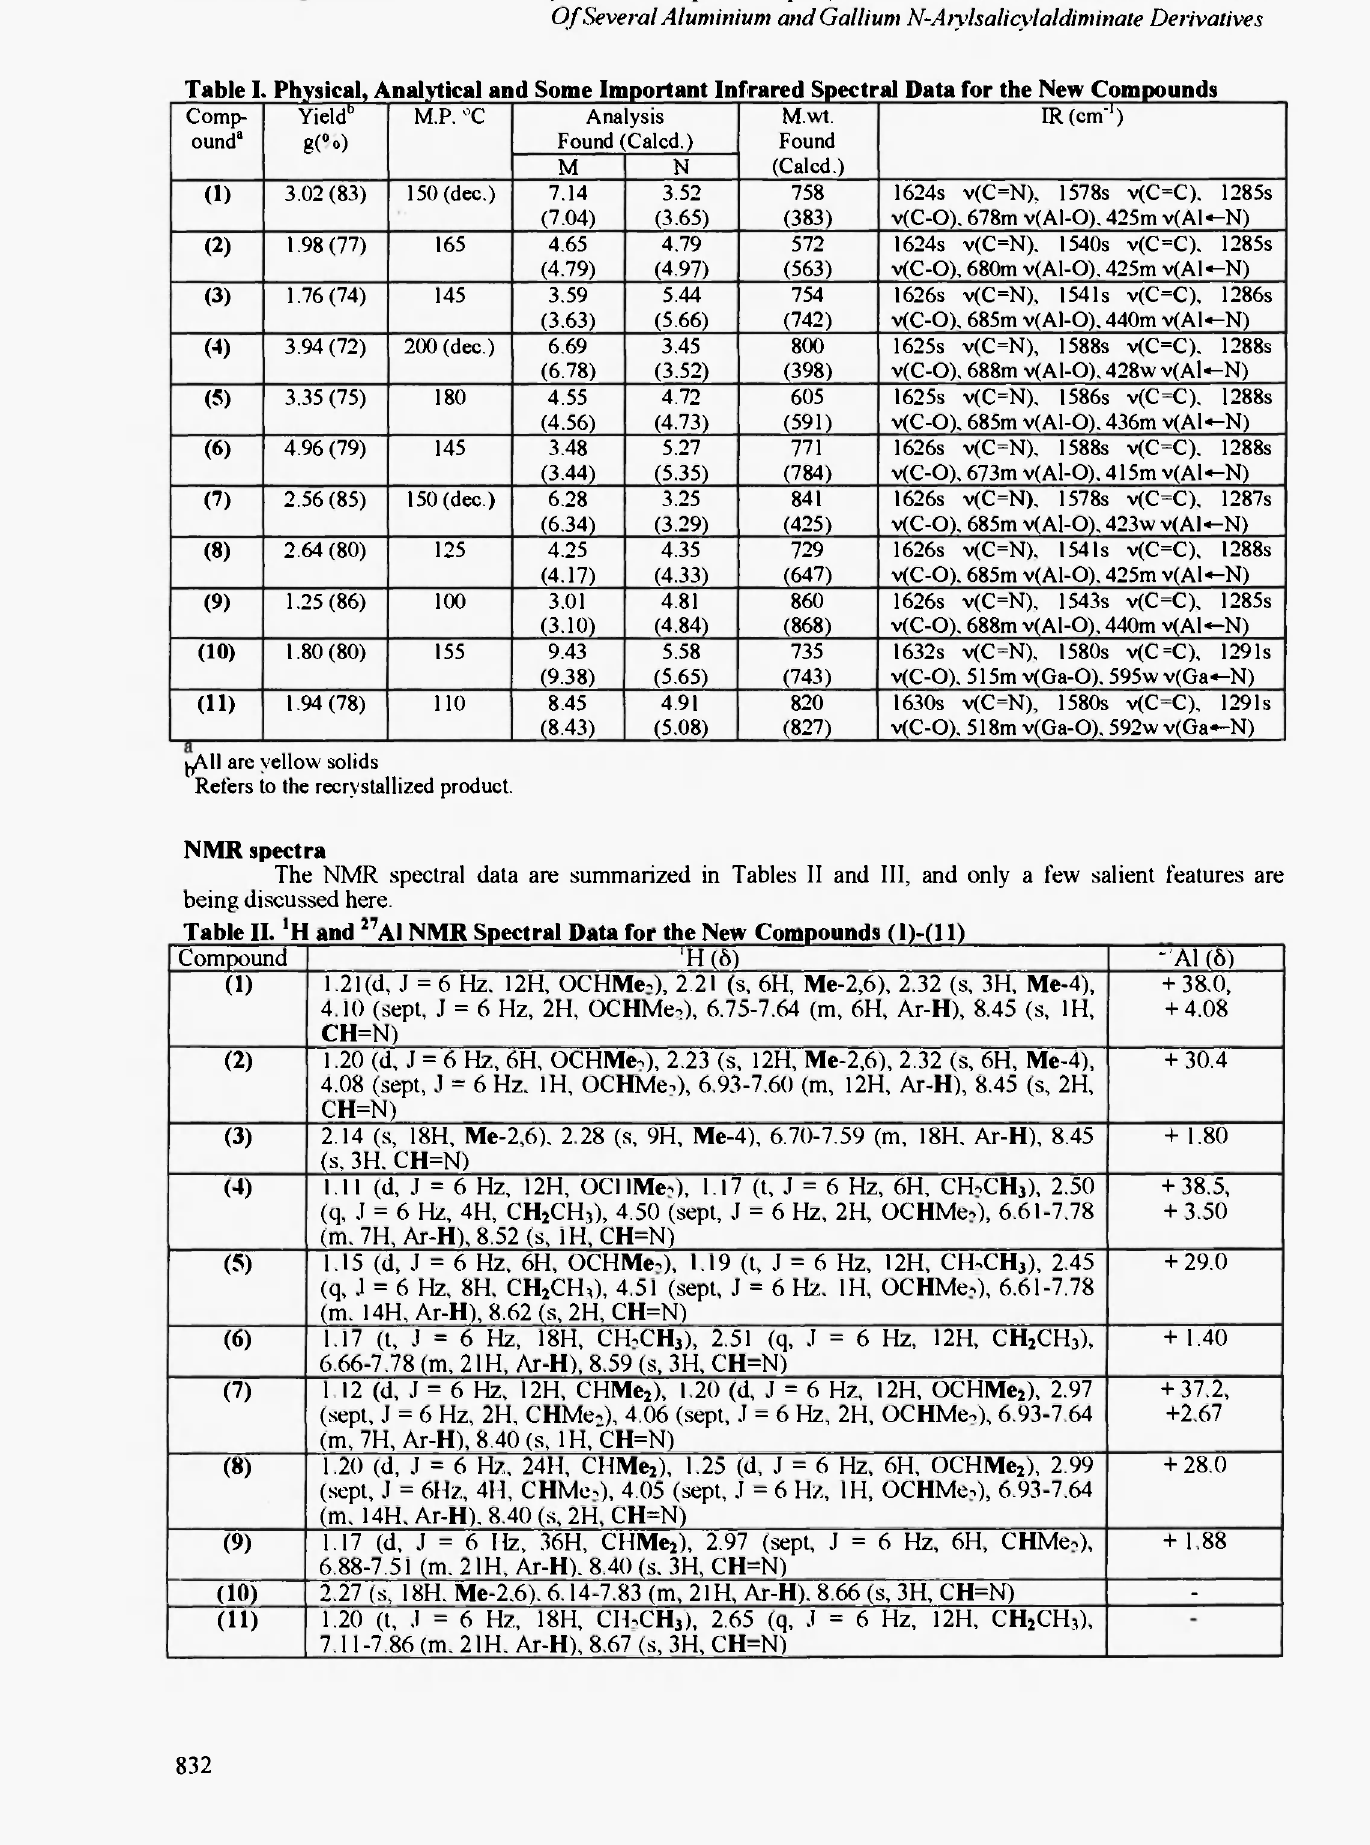
Table I. Physical, Analytical and Some Important Infrared Spectral Data for the New Compounds Comp-